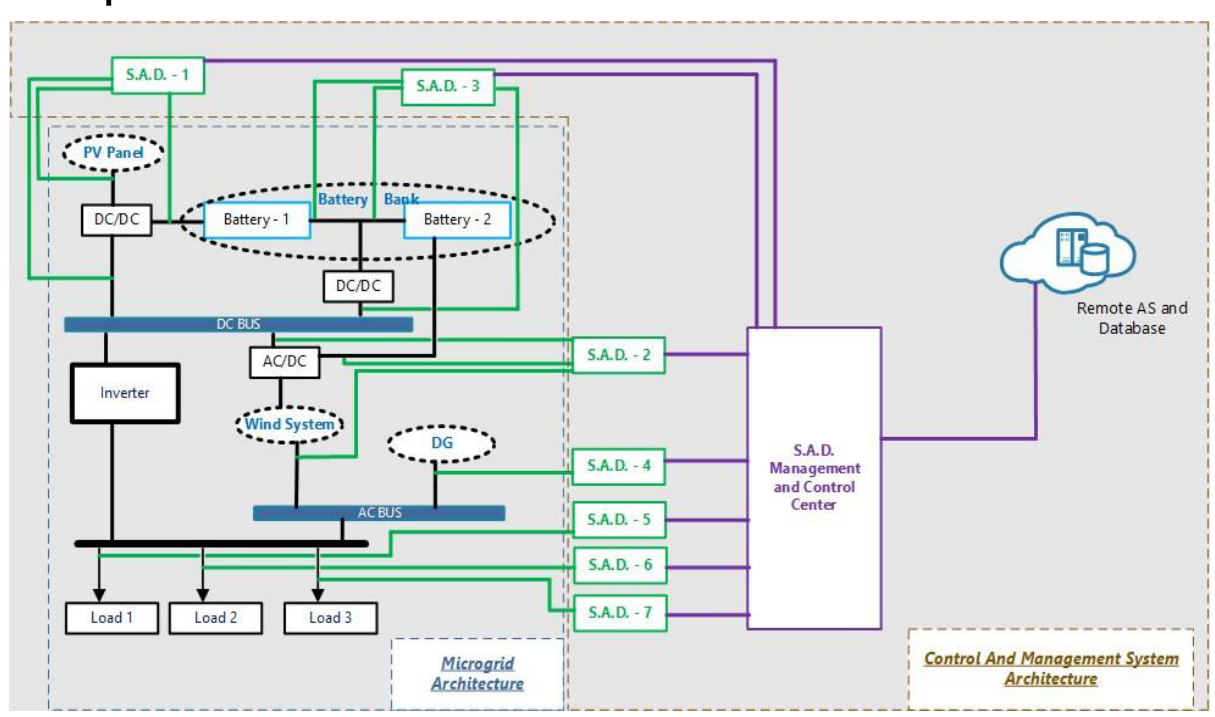
Figure 2 . Control and management system architecture